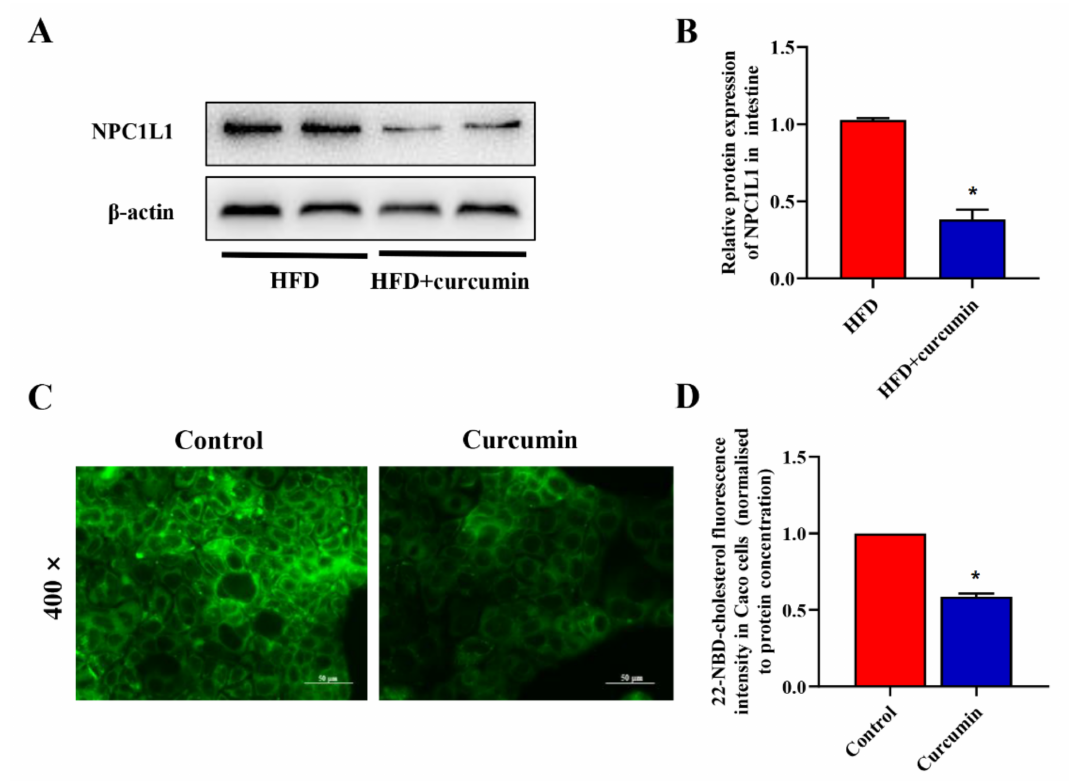
Figure 8. Effects of curcumin on intestinal cholesterol absorption in HFD-fed hamsters. ( A ) The protein expression of intestine NPC1L1 in hamsters by Western blotting assay; ( B ) Grey-scale quanti- tative analysis of Western blotting; ( C ) Representative fluorescent images of Caco-2 cells cultured with 4 µ mol/L 22-NBD-cholesterol and 12 µ mol/L curcumin (400 × magnifications); ( D ) Quantitative analysis of 22-NBD-cholesterol fluoresce intensity. * p < 0.05 compared to HFD group. NPC1L1, Niemann–Pick C1-like protein